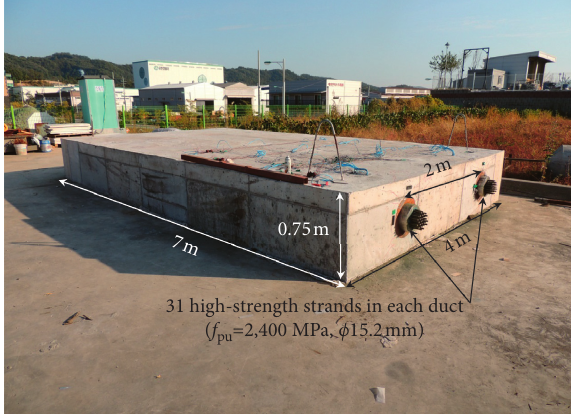
Figure 12: Full-scale test